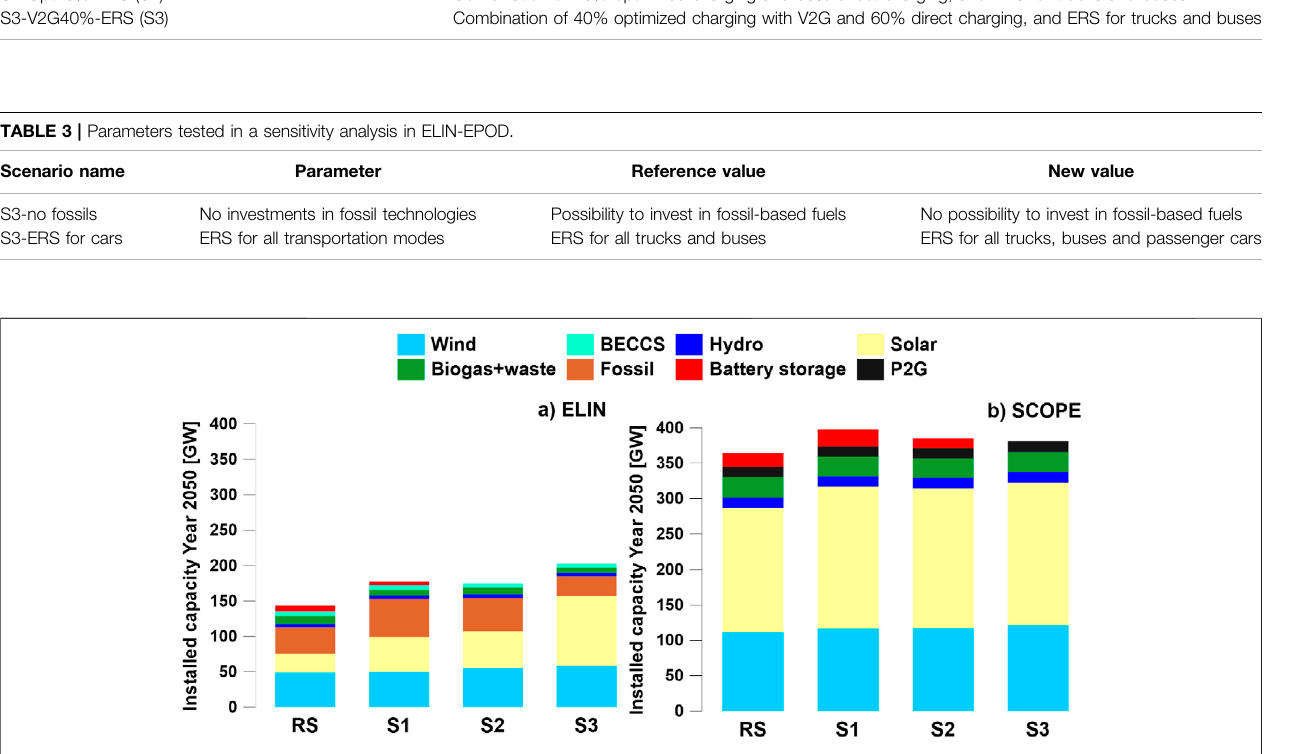
FIGURE 3 | Total capacity installed in Year 2050 in Germany for all the scenarios in (A) ELIN and (B) SCOPE. BECCS, biomass with carbon capture and storage; P2G, power-to-gas.